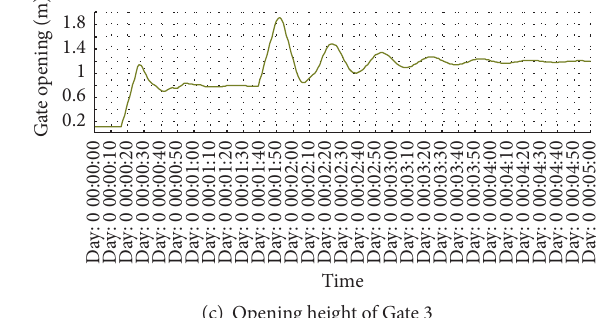
Figure 10: Evolutions of three gate opening heights with 𝑁 = 𝑀 = 10